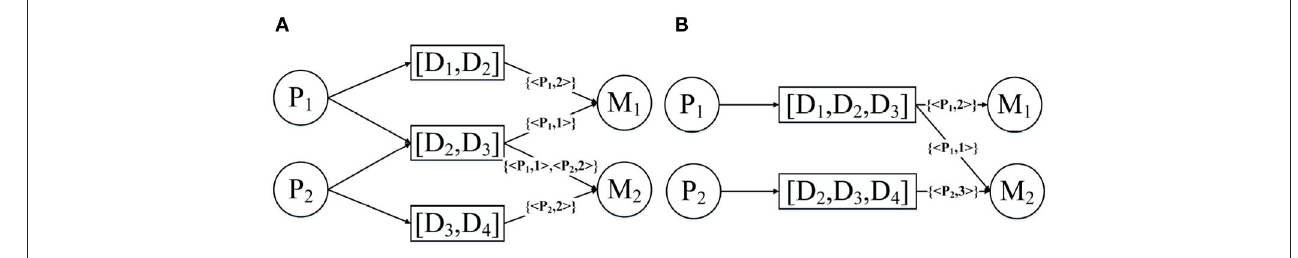
FIGURE 7 | Annotated HIN after (A) 2-disease and (B) 3-disease